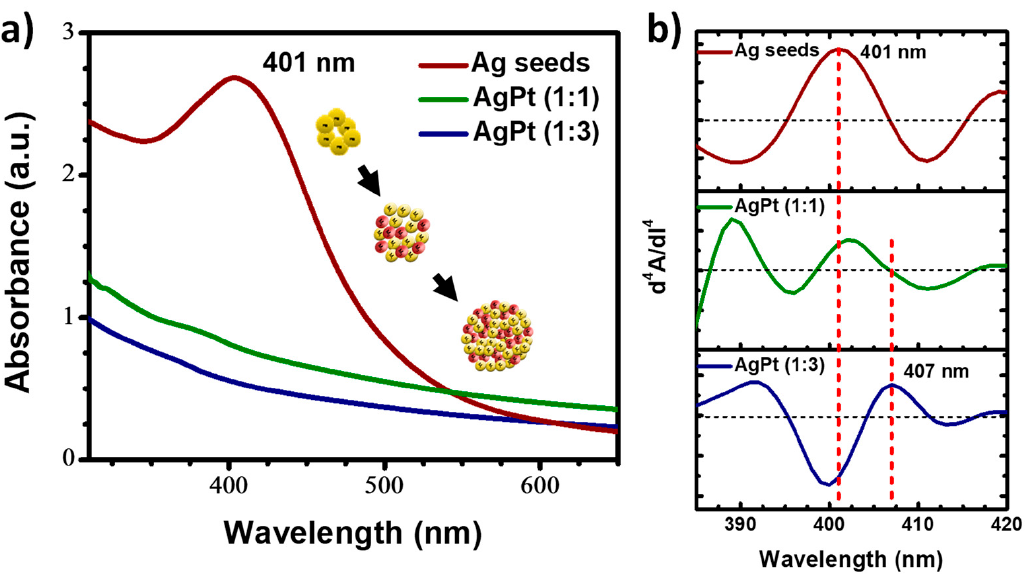
Figure 2. ( a ) UV-Vis absorption spectra and ( b ) fourth-derivative absorption spectra of the obtained Ag seeds, AgPt (1:1), and AgPt (1:3) BNPs.